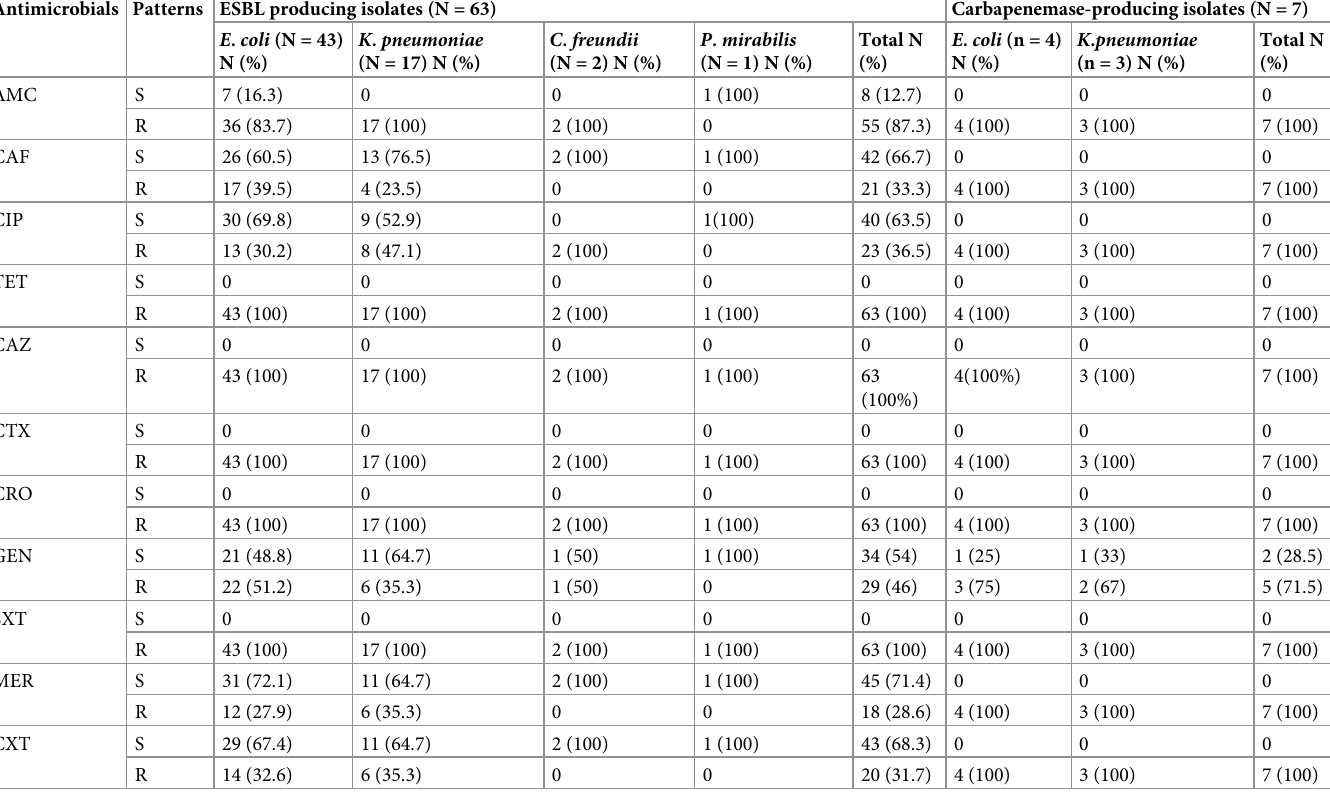
Table 6. Antimicrobial Resistance patterns of ESBLs and Carbapenemase-producing Enterobacteriaceae among food handlers at the University of Gondar Compre- hensive Specialized Hospital and Students’ Cafeterias, Northwest Ethiopia, February to June 2021. Antimicrobials Patterns ESBL producing isolates (N =